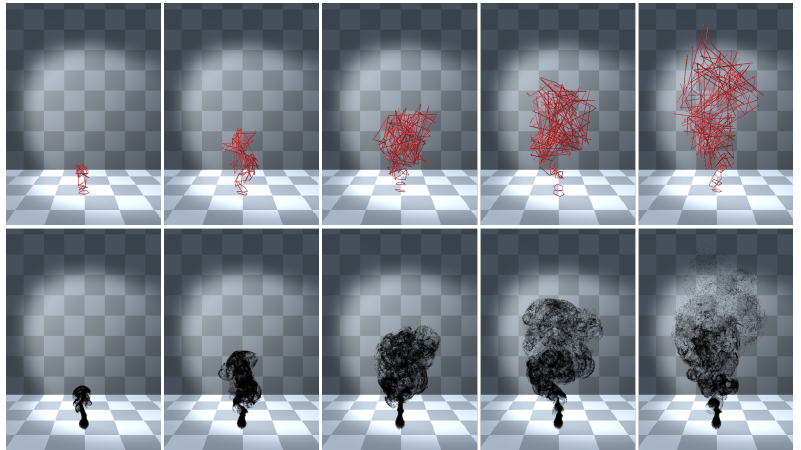
Figure 5. Simulation of a jet rendered with vortex segments ( first row ) and tracer particles ( second row